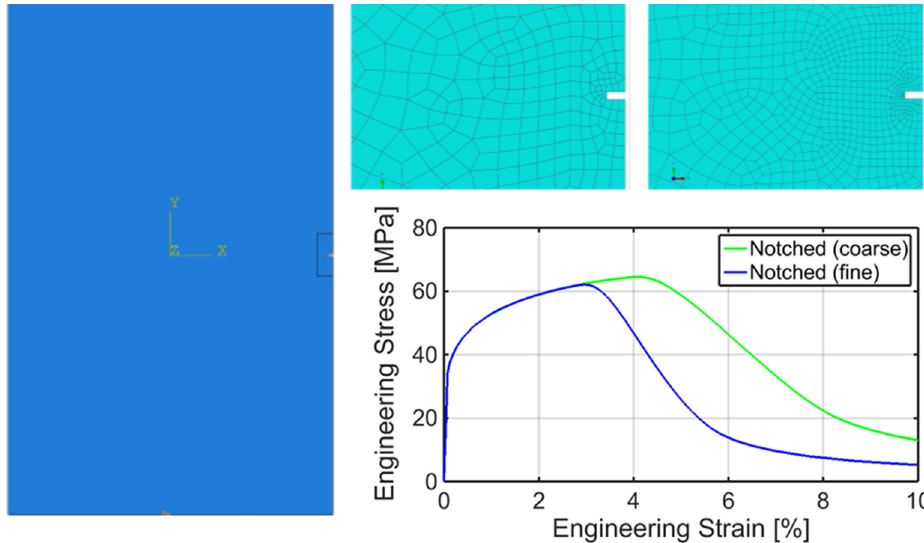
Figure 8. Simulation models of an aluminum region embedding a side crack subjected to uniaxial loading and the resulting nominal stress versus nominal strain